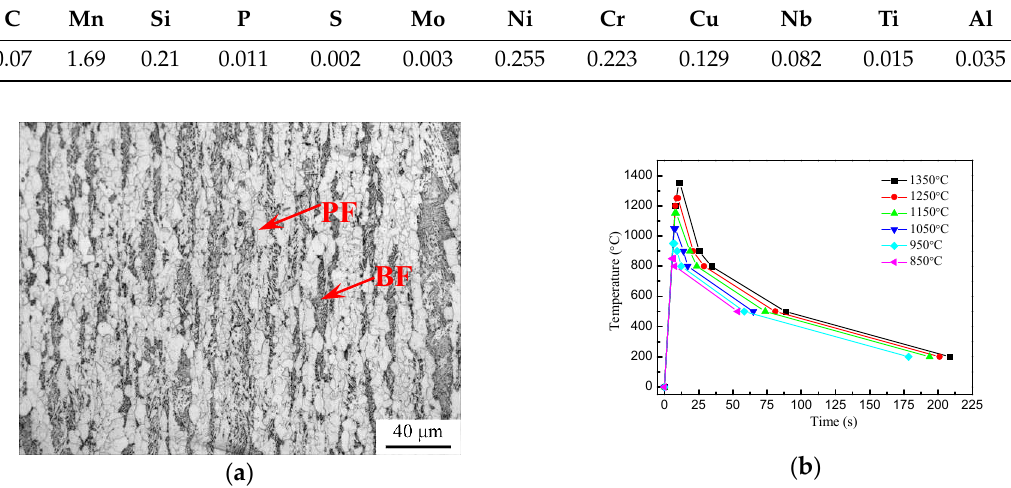
Table 1. Chemical composition (in wt %) of the X80 steel selected in the present study.